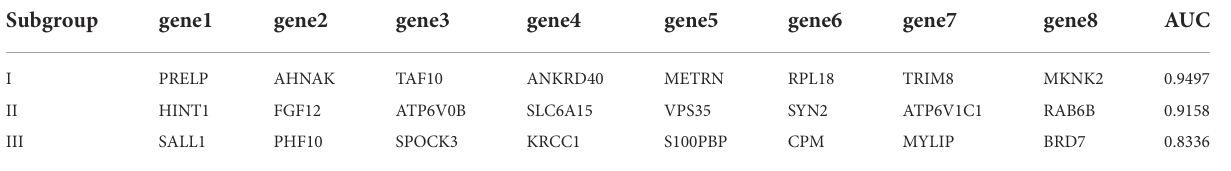
TABLE 2 Subgroup best combined diagnosis